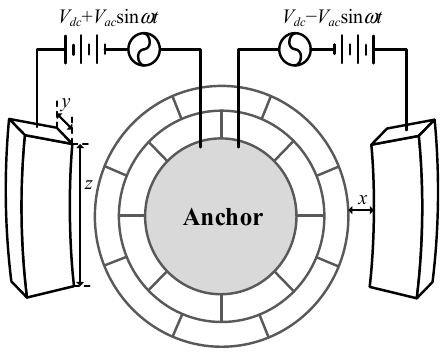
Figure 4. Infliction of the drive voltage .